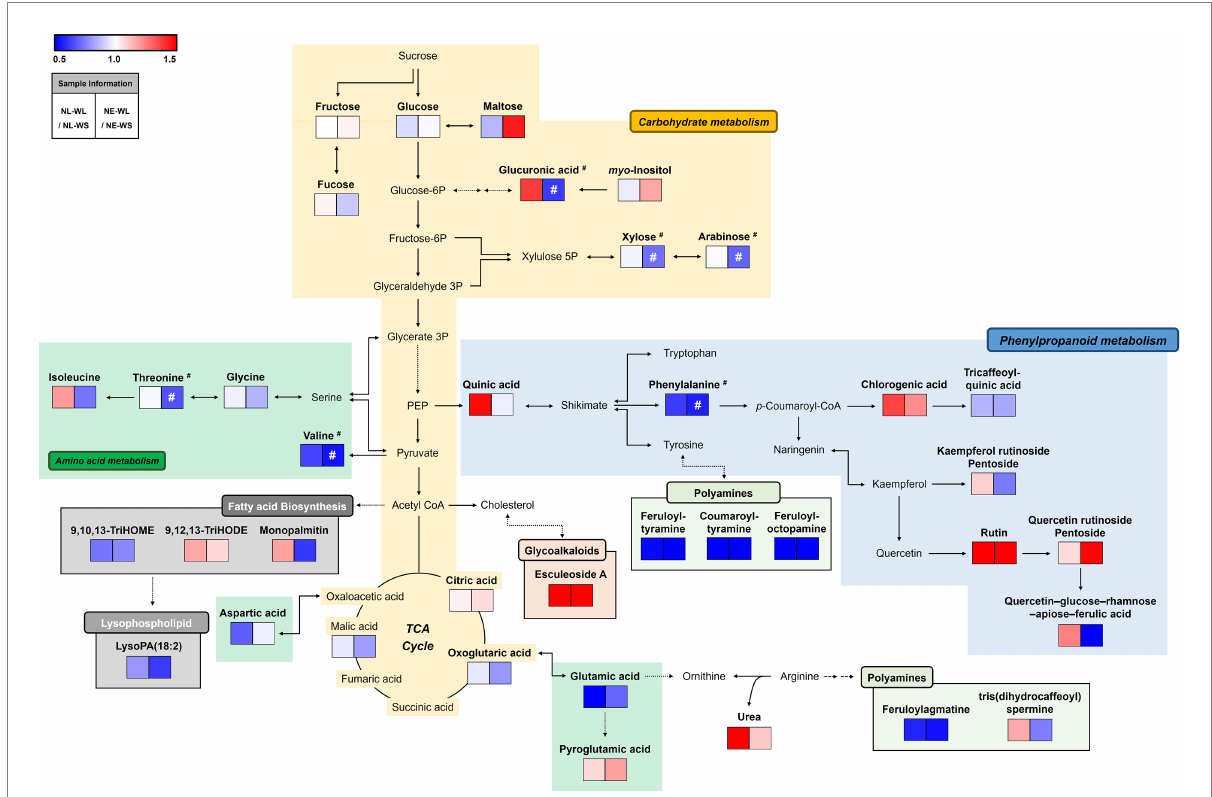
FIGURE 2 Schematic diagram of the metabolic pathway analysis and the relative changes in metabolites by water limitation in two different soils. The metabolic pathway was modified from the KEGG pathway database (https://www.genome.jp/kegg/pathway.html; URL accessed on 17 February 2022). The colored squares (blue to red) indicate fold changed normalized by water sufficient condition for each soil nutrient condition. # Significantly differed metabolites between NE-WS and NE-WL ( p < 0.05, Student’s t